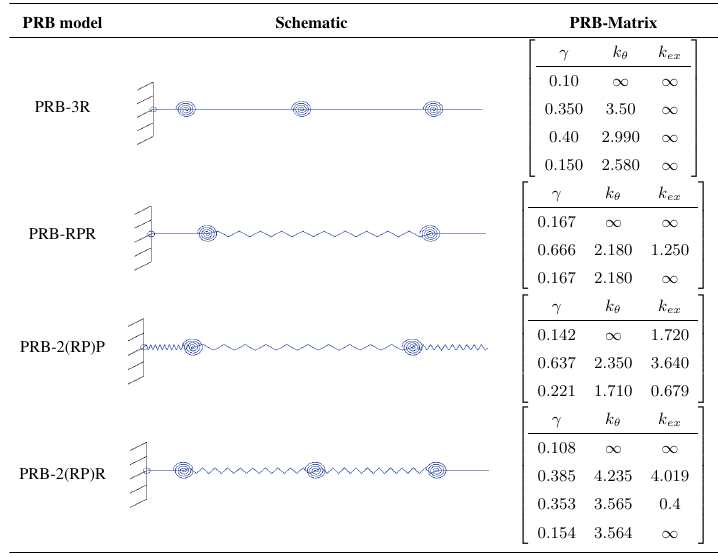
Table A1. List of the PRB Matrix values for the PRB Models used in the paper. First row of the PRB matrix of a PRB-FSM model with (cid:3) (cid:2) (cid:3) (cid:2) (cid:3) n torsion springs is (cid:2) 0 . 5 /n , the last row ( n 1th) is 1 /nn and the remaining rows are 1 /nn . If extension effect is desired, ∞∞ + ∞ ∞ k ex will be 2 n , 2 n and n for the first, the last and the remaining rows of the PRB Matrix of the PRB-FSM model with n torsion springs, respectively. The parameters of the PRB-RPR and PRB-2(PR)P are obtained from Venkiteswaran and Su (2014) which were optimized for short Timoshenko type